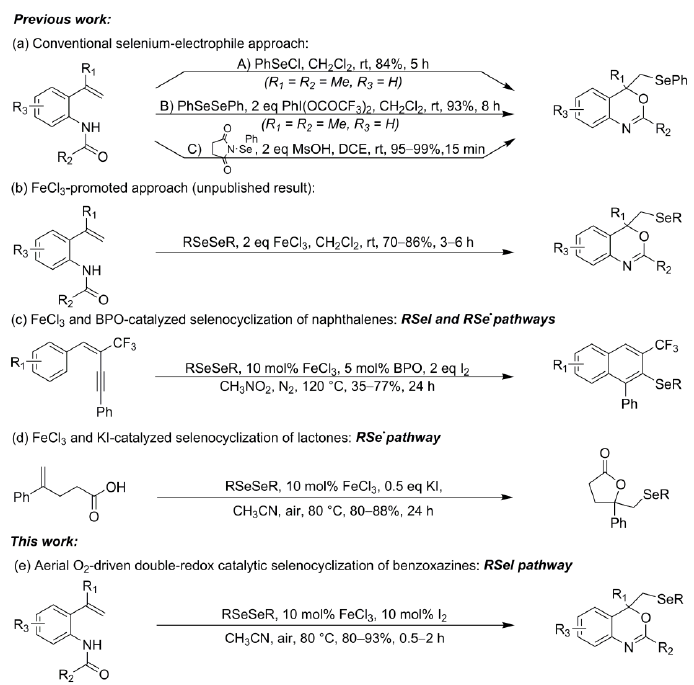
Figure 2. Previous and current selenocyclization methods.